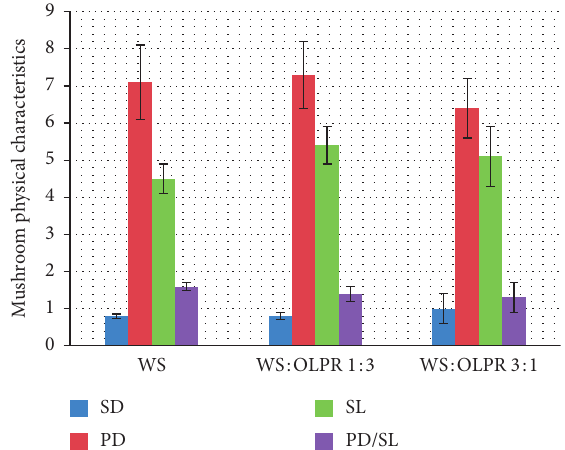
Figure 2: Physical characteristics of mushrooms obtained in tested substrates (SD: stipe diameter, PD: pileus diameter, SL: stipe length, PD/SL: pileus diameter/stipe length, and ns: no